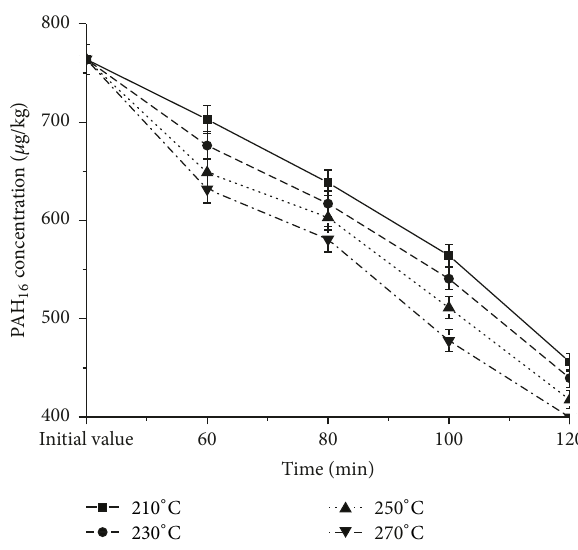
Figure 4: Effect of deodorization on PAH 16 .